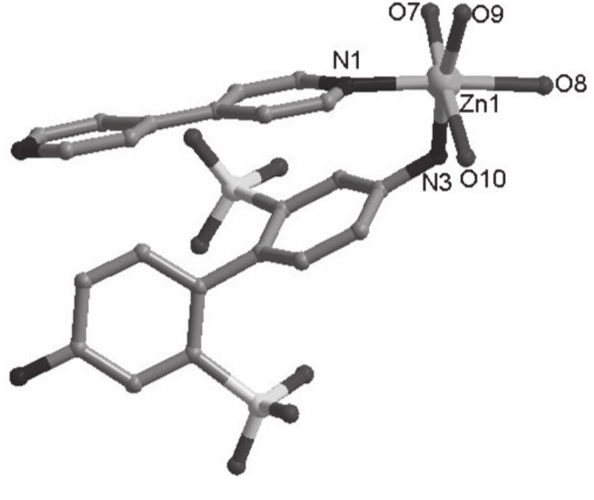
Table 1: Data collection and handling.